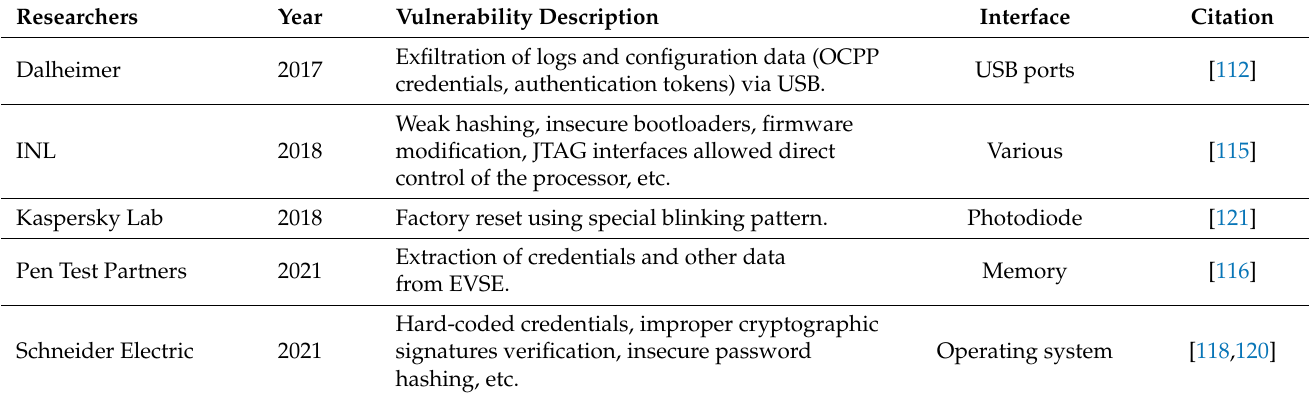
Table 4. EVSE maintenance interface